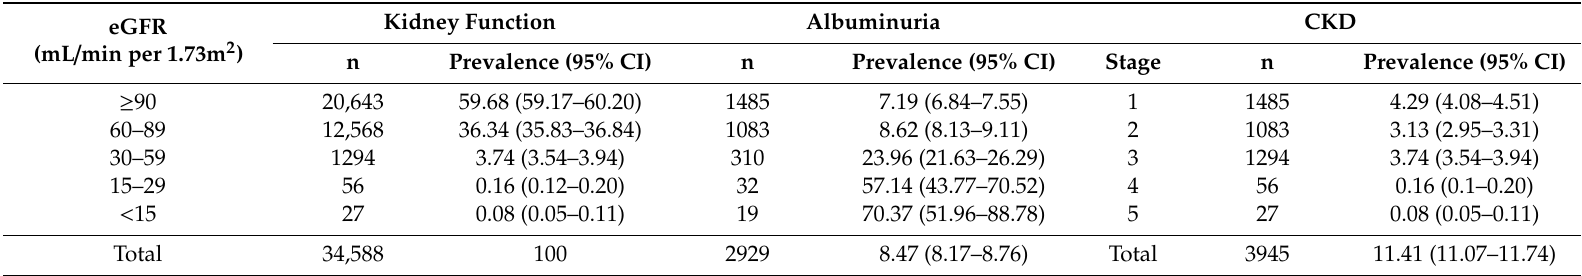
Table 2. Prevalence of indicators of kidney function in the study